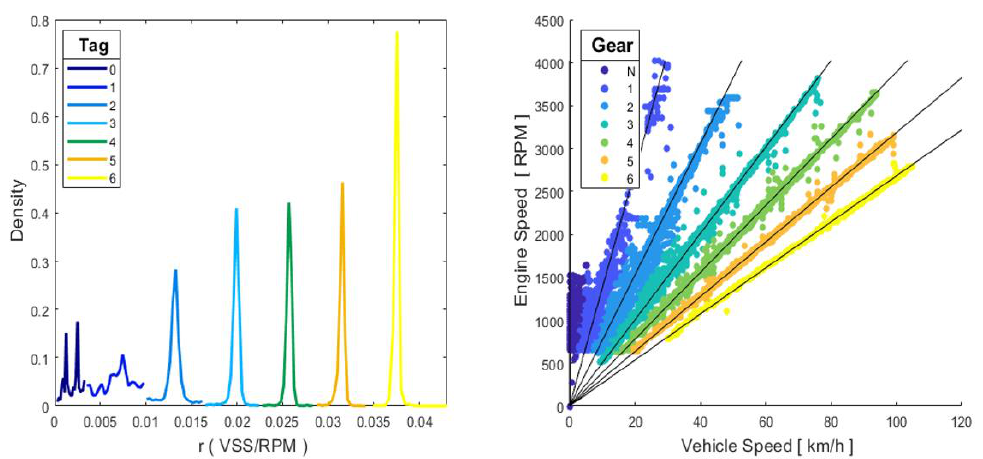
Figure 4. Labels obtained through K-means algorithm. CT-generated results.